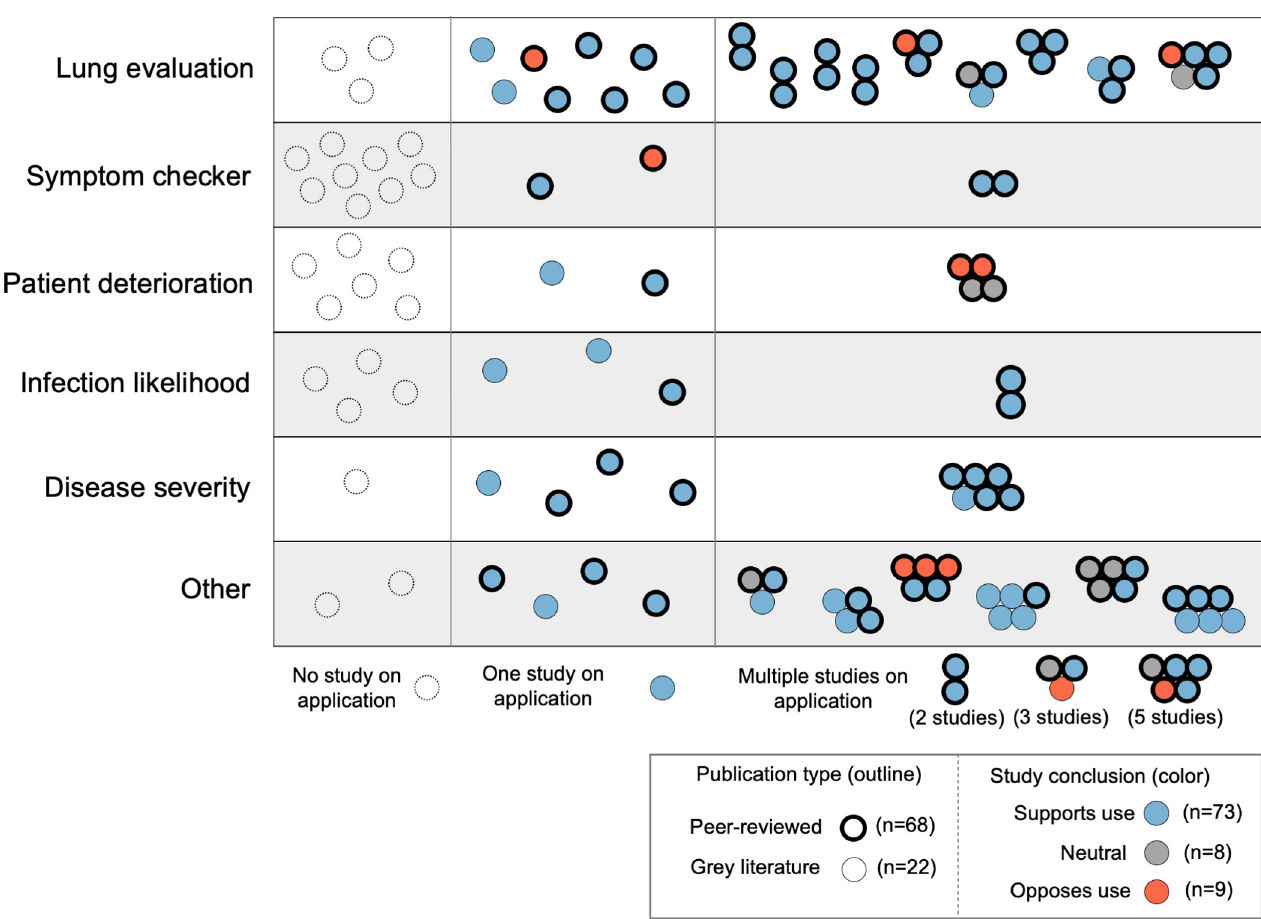
Fig 4. Evaluation studies of applications, by study conclusion and publication type. Note: Multiple studies on a single application are represented by a cluster of bubbles. Nine documents are each represented by two separate bubbles in this figure, including 3 documents that present evidence on two applications and 6 that presented evidence from both a validation study and a non-validation (‘other’) type of study.